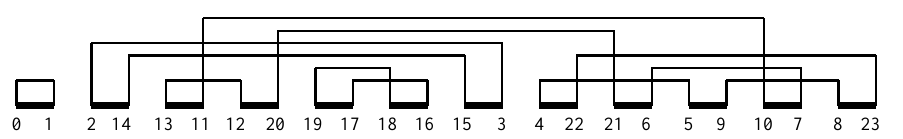
Fig. 1: Breakpoint graph for human-mouse X chromosome